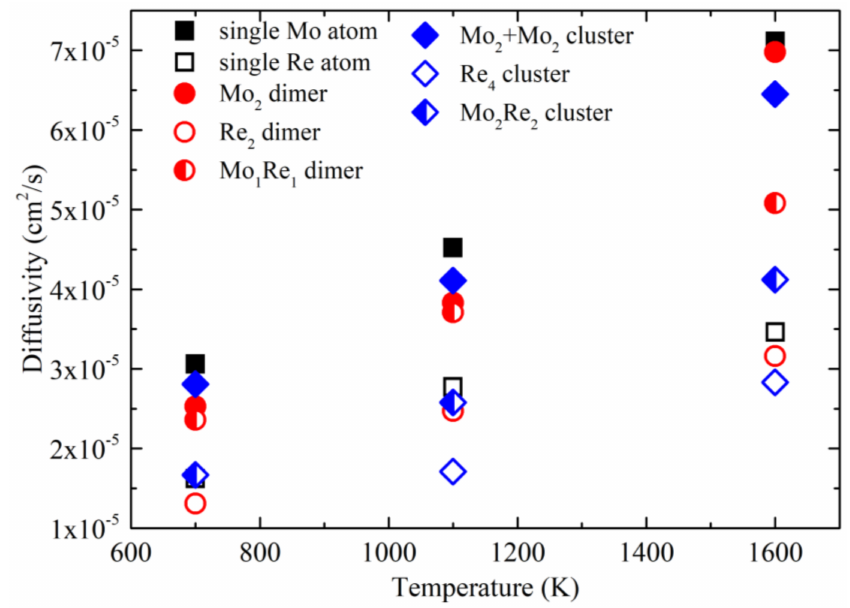
Figure 8. Diffusivity of Mo and Re clusters in liquid Na at different